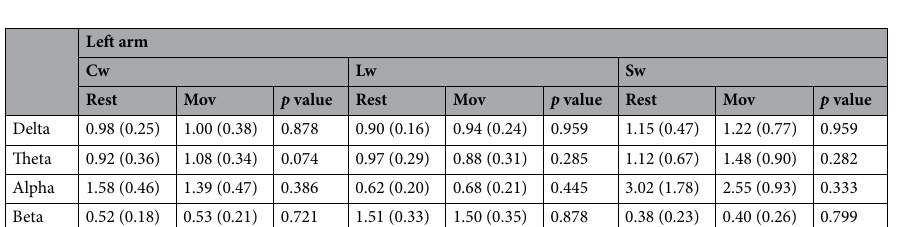
Table 2. Wilcoxon test for Cw, Lw and Sw between the two different experimental conditions (Rest and Mov) for each EEG frequency band during the trials performed with the left arm.